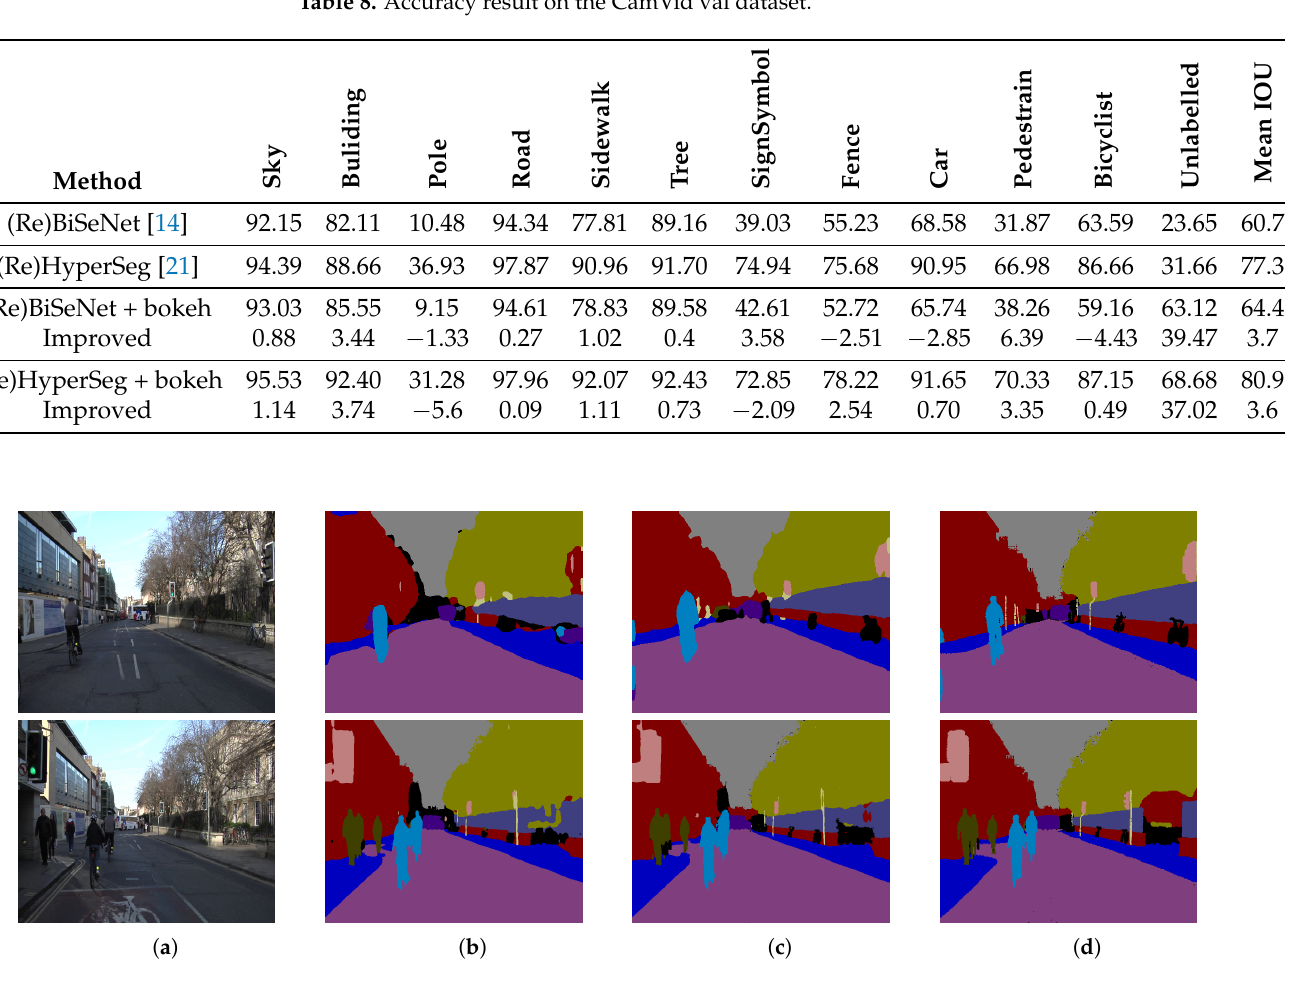
Figure 7. Examples of the output before and after adding the bokeh module on the CamVid